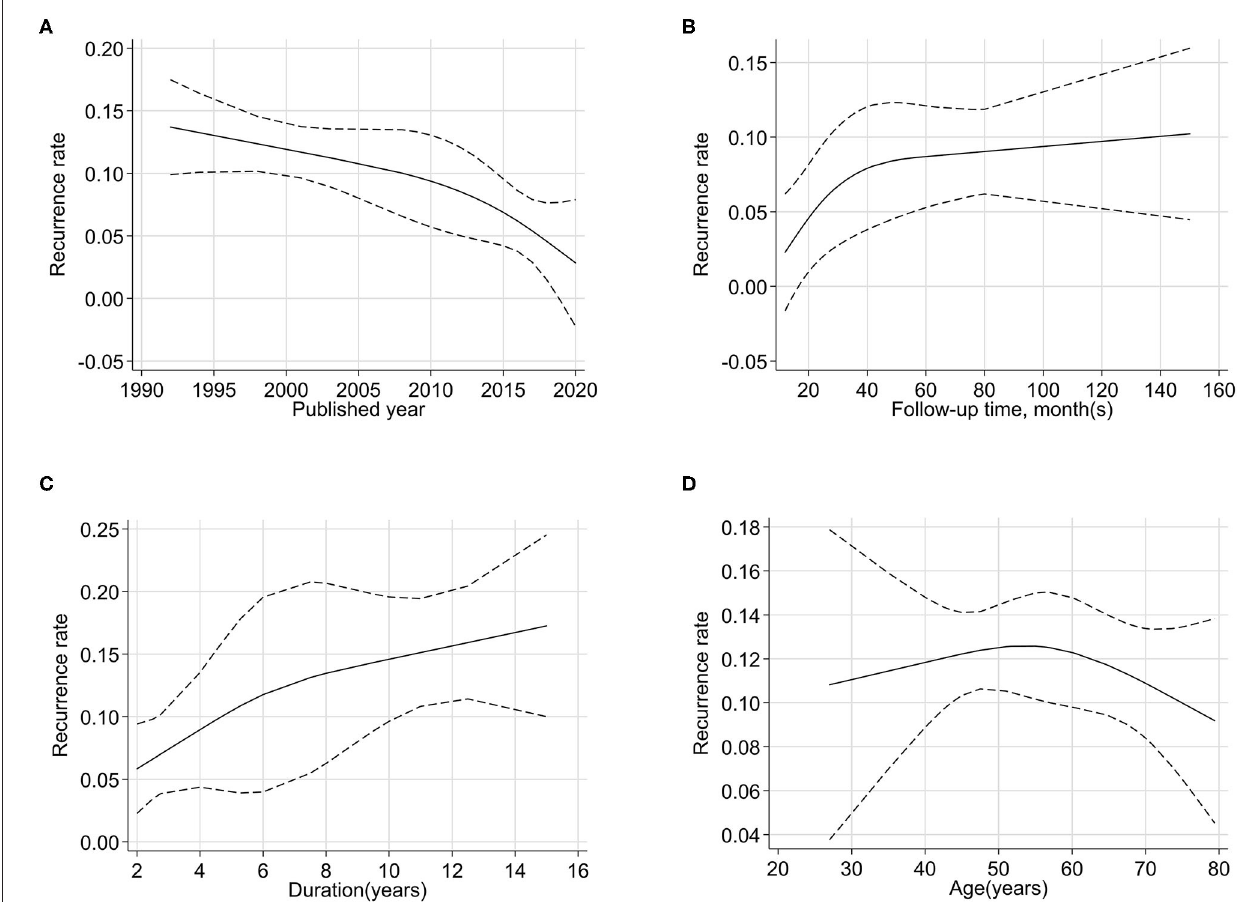
FIGURE 3 | Non-linear dose–response analysis between quantitative factors [published year (A) , follow-up time (B) , duration (C) , and age (D) ] and the recurrence rates of primary trigeminal neuralgia after microvascular decompression.